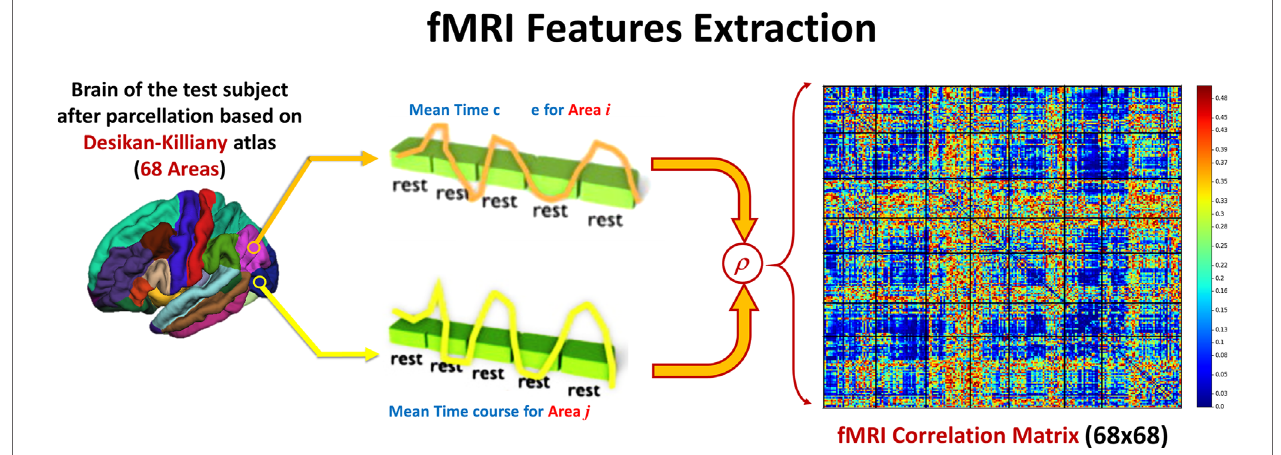
FIGURE 3 | For each couple of areas, the correlation coefficient between the time courses is calculated to form one 68 × 86 feature